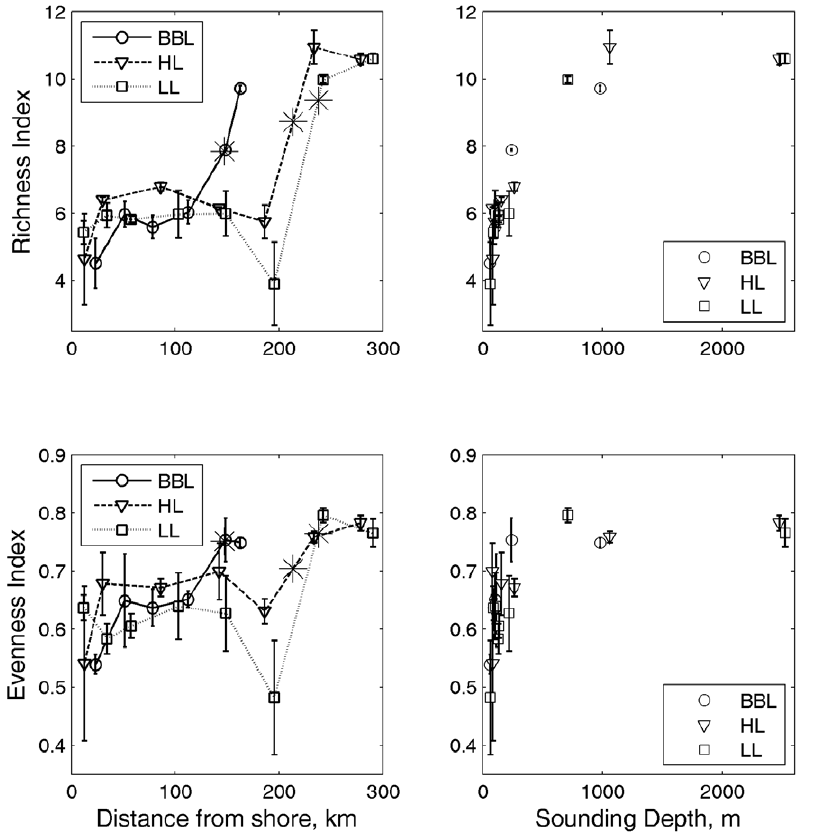
Figure 3. Relationships between copepod species richness and evenness and distance from shore and depth on the Scotian Shelf. Data on adult copepods were collected by the Atlantic Zone Monitoring Program during spring and fall cruises on the Scotian Shelf between 1999 and 2008. Richness index based on rarefaction to 50 individuals.Bars indicate standard error. The * symbol indicates the location of the shelf break, defined as the 200 m isobath, along each transect. BBL – Brown’s Bank Line; HL – Halifax Line; LL – Louisbourg Line.